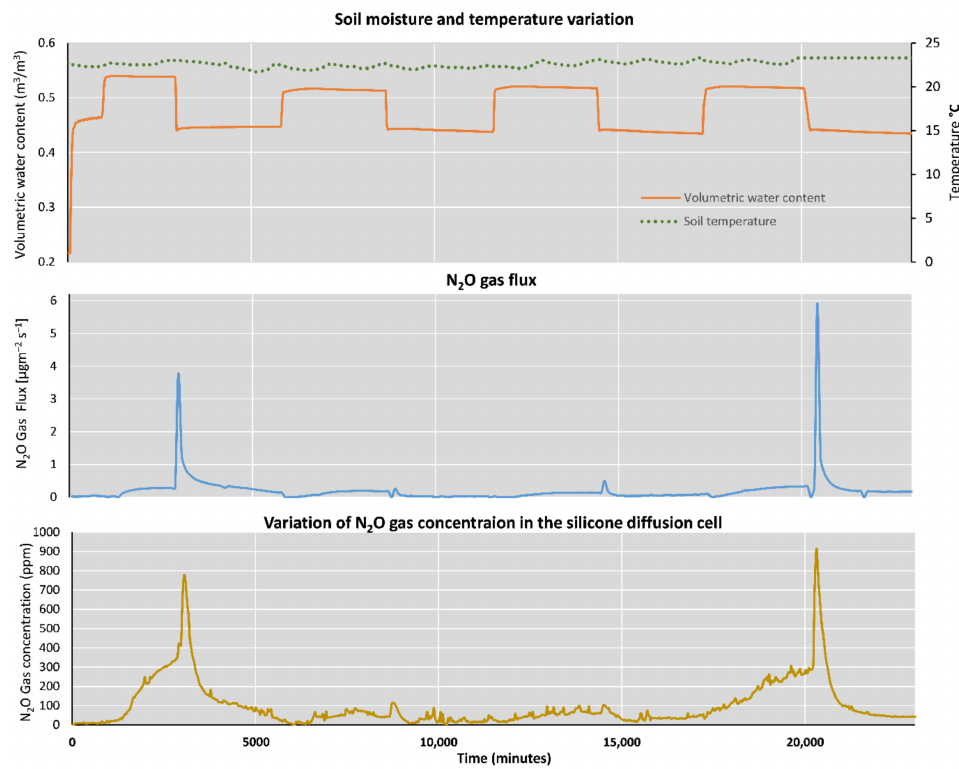
Figure 6. Temporal variations in the N 2 O gas concentrations in the silicone diffusion cell and N 2 O gas flux from the headspace, soil temperature, and moisture levels in experiment 1.